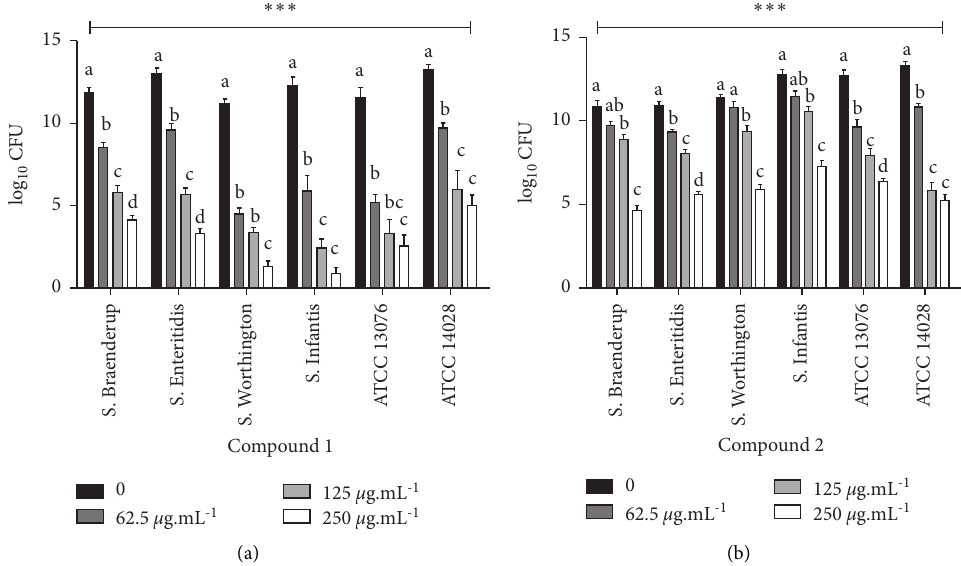
Figure 1: Quantification of viable cells in log 10 CFU of Salmonella spp. treated with different concentrations of 4,5-dihydro-1H-pyrazole-1- carboximidamide hydrochlorides (trifluoromethyl)phenyl-substituted, compound 1 and bromophenyl-substituted, compound 2 , using ANOVA and Tukey’s test. ∗∗∗ ( p < 0 . 05) indicates a significant difference. Different letters for each concentration represent a significant difference between them by the means test ( p < 0 .